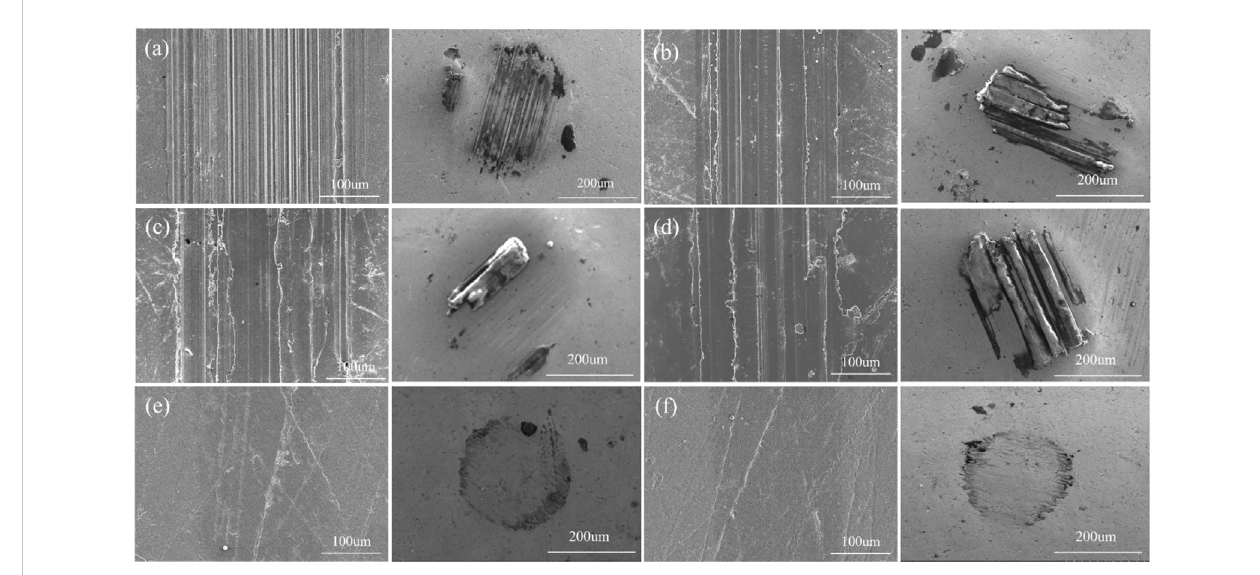
FIGURE 9 Wear tracks and wear scars of the PI substrates treated with different graphite target currents: (A) 0.0 A (B) 1.0 A (C) 1.5 A (D) 2.0 A (E) 2.5 A (F) 3.0 A.